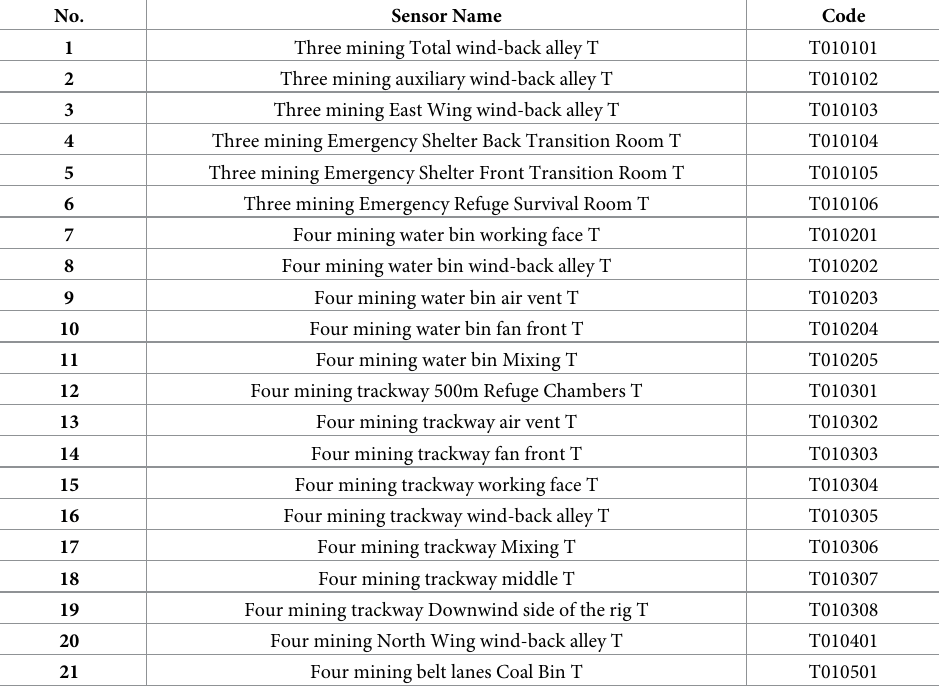
Table 3. Code of sensors in Case Study mine